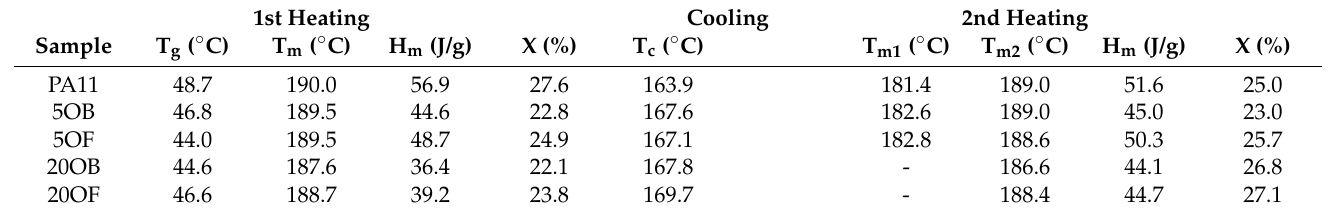
Figure 15. DSC curves of unmodified PA11 and composites, second heating; samples with 20% of diatoms. Table 4. Thermal characteristics of PA11 and composites with silane. Table 5. Thermal characteristics of composites without silane obtained in a previous work